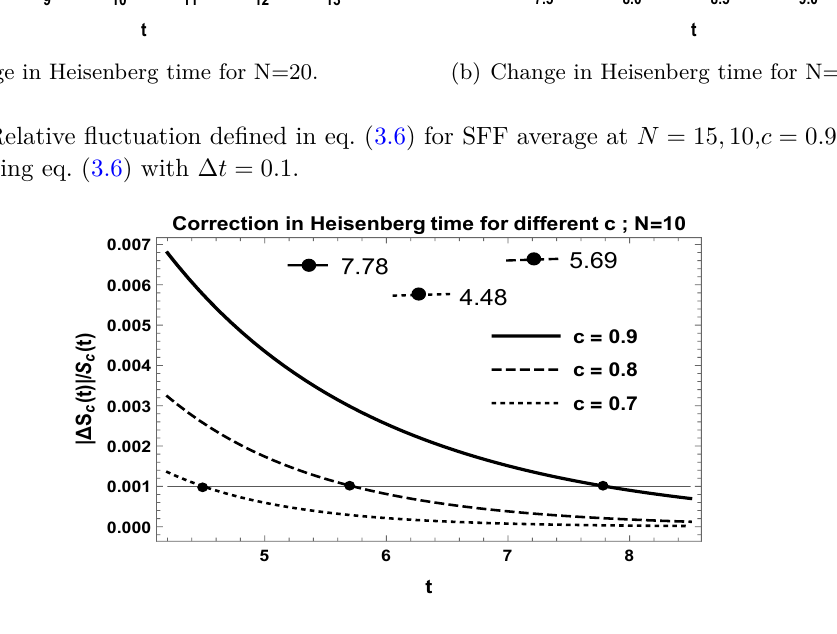
Figure 12 . Heisenberg time from SFF average computed for zeroth order saddle point method solution for c=0.9,0.8,0.7 for